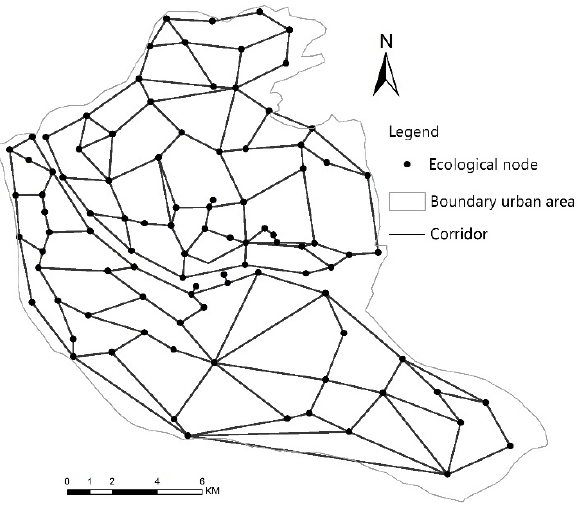
Figure 11. Distribution of ecological nodes and corridors in Fuzhou City. A total of 155 corridors were built, including 71 corridors in Cang Shan District, 34 corridors in Gu Lou District, 16 corridors in Tai Jiang District, and 34 corridors in Jin An District. The corridor densities of the ecological network are 1.16 km/km 2 , 1.62 km/km 2 , 1.33 km/km 2 and 1.05 km/km 2 , respectively, in Cang Shan District, Gu Lou District, Tai Jiang District, and Jin An District. The index α , index β , and index γ of the ecological networks in Gu Lou District and Tai Jiang District are higher than those in Cang Shan District and Jin An District, and have the lower cost ratio, which indicates that the ecological networks in Gu Lou District and Tai Jiang District have higher connectivity, while the ecological networks in Cang Shan District and Jin An District have higher cost efficiency and are more economically flexible (Table 8). Table 8. The corridor structure metrics for the ecological network planning. Corridor Nodes Number